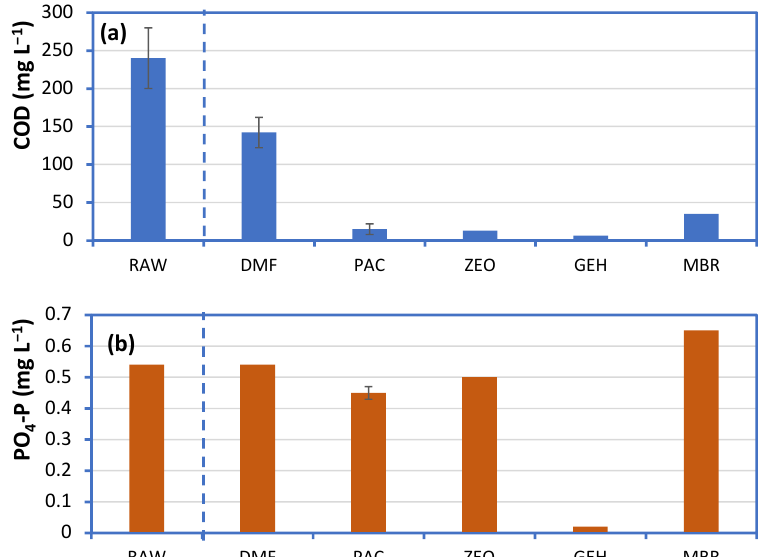
Figure 2. Quality of the permeate ( a ) COD and ( b ) PO 4 -P during short-term operation of a membrane reactor with different additives, treating 60 L synthetic greywater (RAW) (DMF: Direct membrane filtration; PAC: Powder activated carbon; ZEO: Powder zeolite; GEH: Powder iron hydroxide; MBR: Activated sludge). Additive concentration was equal to 0.9 g L − 1 in all cases.